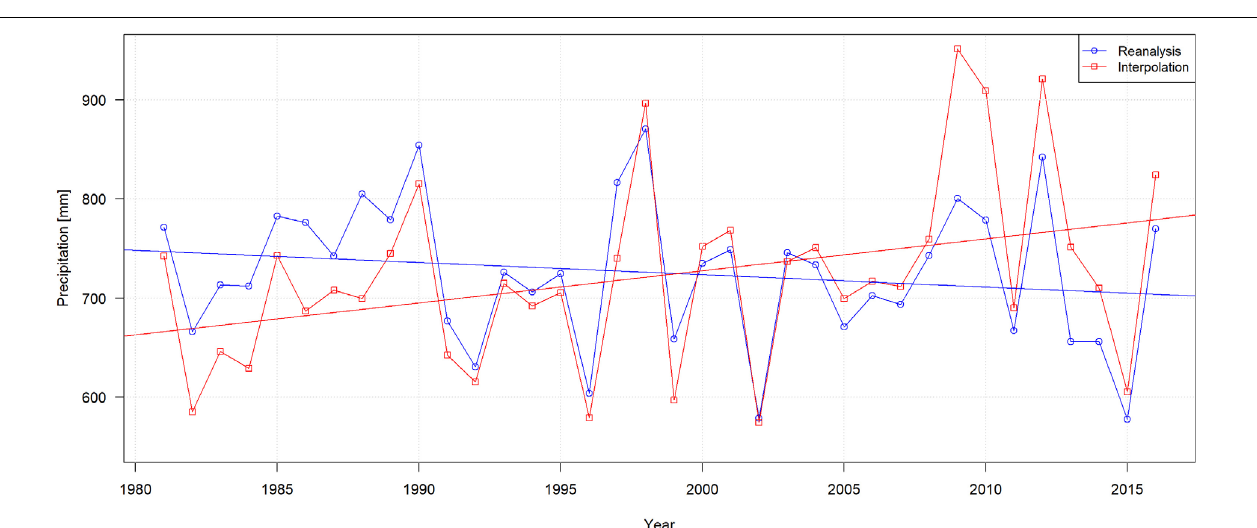
Long-term reanalysis and interpolated stations data curves have the same shape. Gradual increasing trends of temperatures and surface solar radiation are indicators of warming over the past few decades. Trends are very similar for temperature and WND, but differ for precipitation ( Figure 5